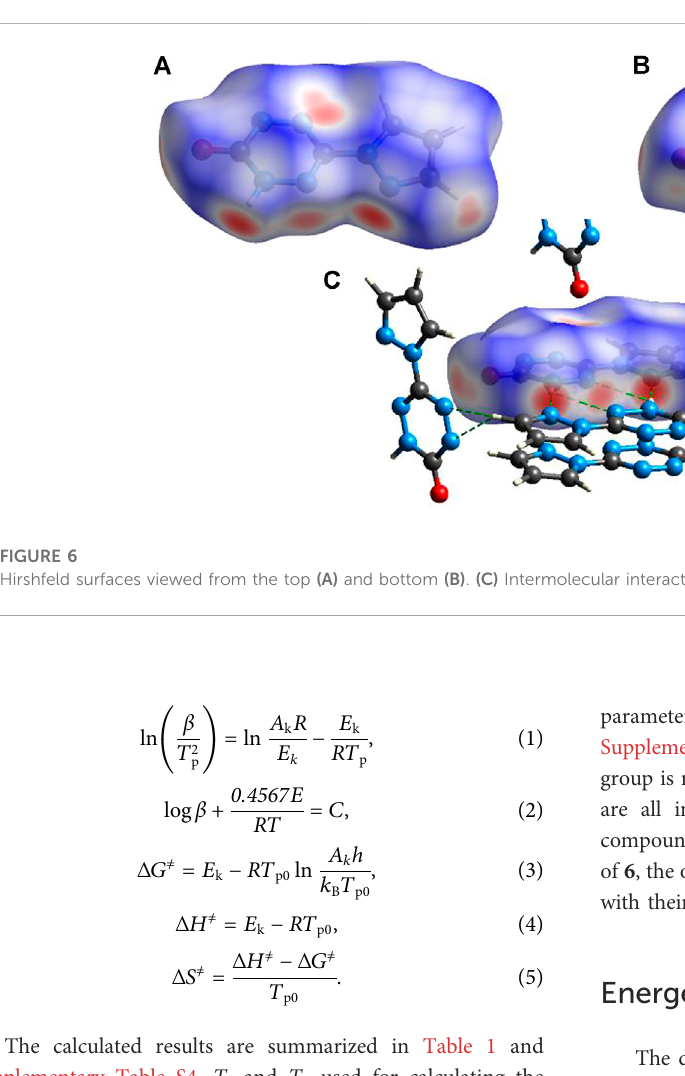
obtain their energetic properties. The results are listed in Table 2.